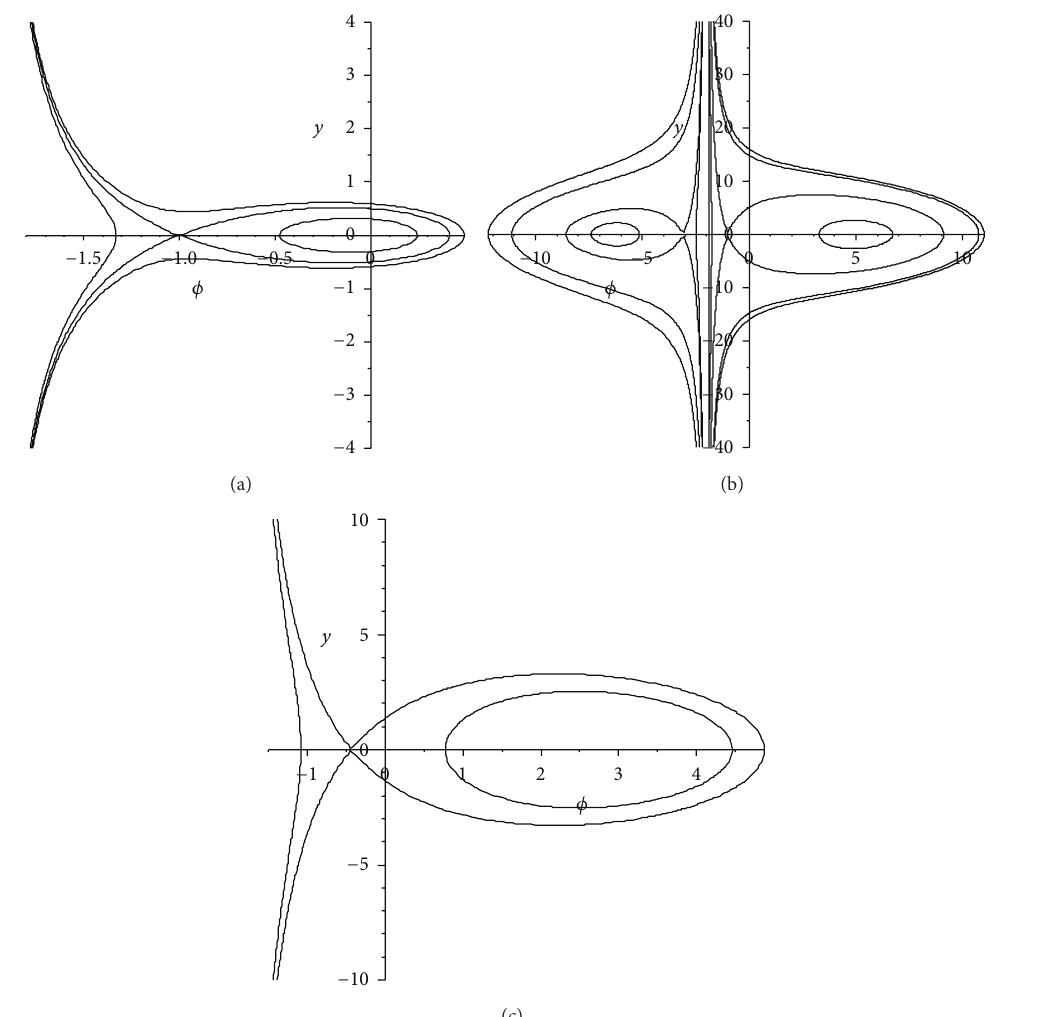
Figure 1: Phase portraits of (10) for 𝜙 ̸= −𝑐 . (a) The case for −(1/2)𝑐 2 ≤ 𝑔 < (1/4)𝑐 2 , 𝐹(𝜙 + ) < 0 . (b) The case for 𝑔 < −(1/2)𝑐 2 , 𝐹(𝜙 − ) < ) < 0 . (c) The case for 𝑔 < −(1/2)𝑐 2 , 𝐹(𝜙 0, 𝐹(𝜙 +